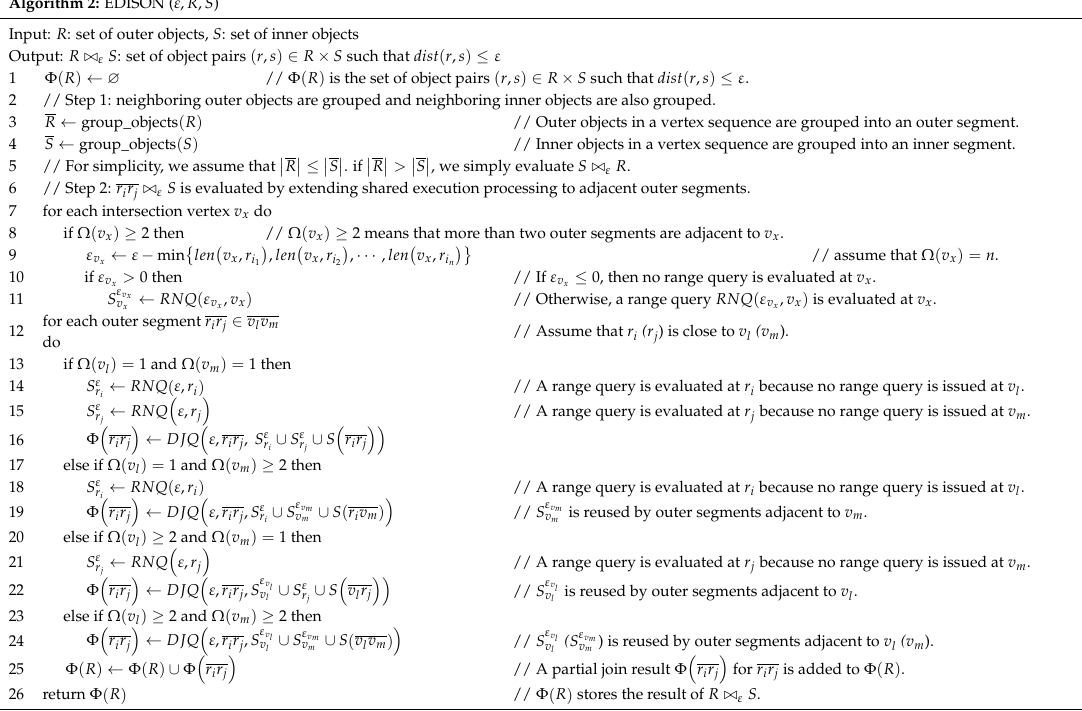
Algorithm 2: EDISON ( ε , R , S )